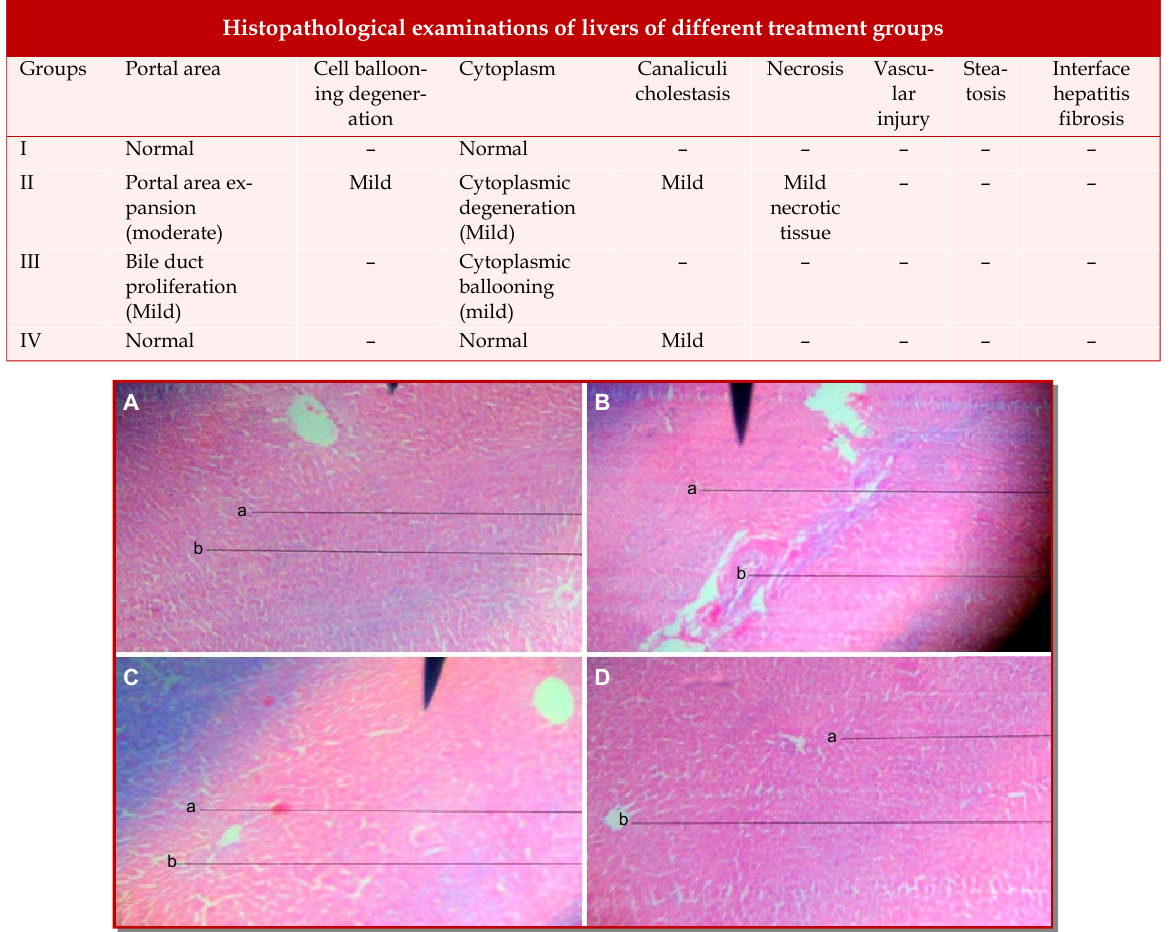
Figure 1: A) Control group a: Normal hepatocytes b: Normal sinusoids, B) Toxic group a: Cytoplasmic degeneration b: Portal vein expansion, C) Standard group a: Normal hepatocytes b: Normal sinusoids, D) Experimental group a: Normal hepatocytes b: